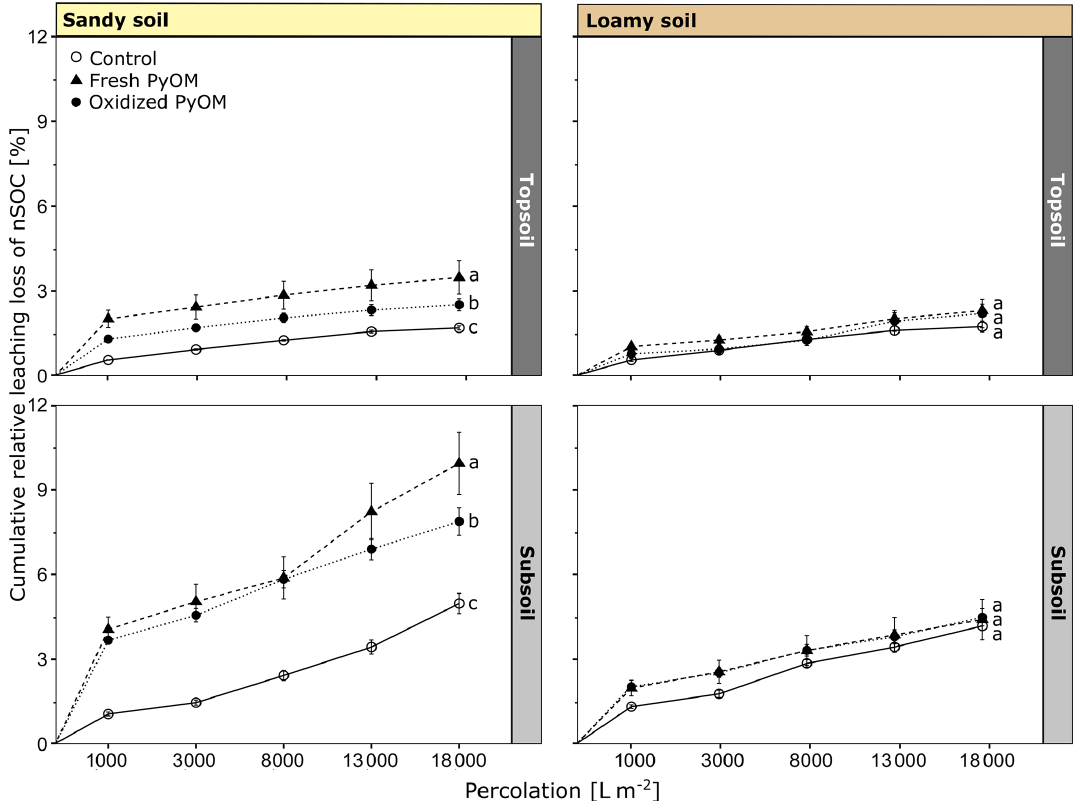
Figure 3. Cumulative leaching loss of native soil organic carbon (nSOC) from sandy and loamy topsoil and subsoil for controls and columns with addition of fresh and oxidized PyOM. The significant differences ( p < 0 . 05) of the total percolated nSOC after 18000Lm − 2 are indicated by letters. All values are shown with propagated